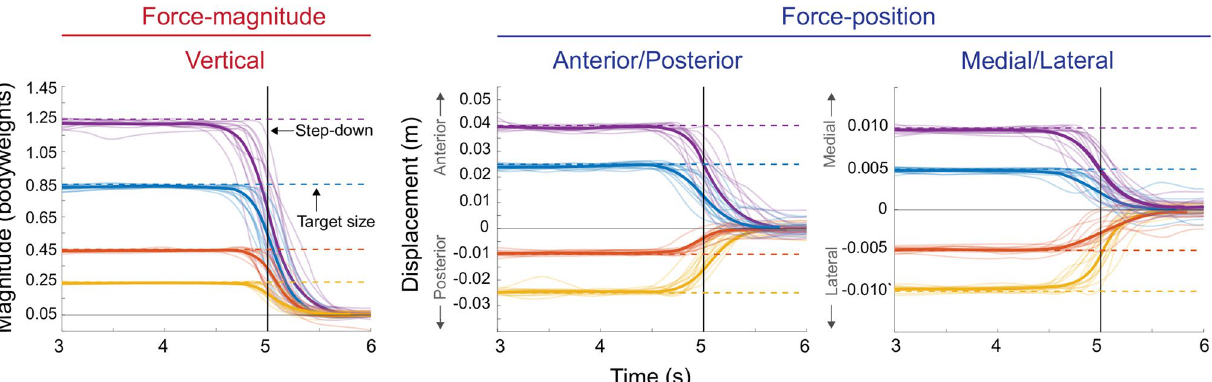
Figure 4. The average step-down response for each participant at each target step size (color lines) and the average of the average response (bold colored lines). The vertical line represents when the step function steps down from the current step target size (dashed lines) to 0.05 bodyweights for force-magnitude control or 0 cm for force-position control (base values). Here the 2 seconds before the step-down are shown and the 1 second after the signal returns to its base value. Within this timeframe, we evaluated the fall times as participants stepped down from the step target size back down to the base